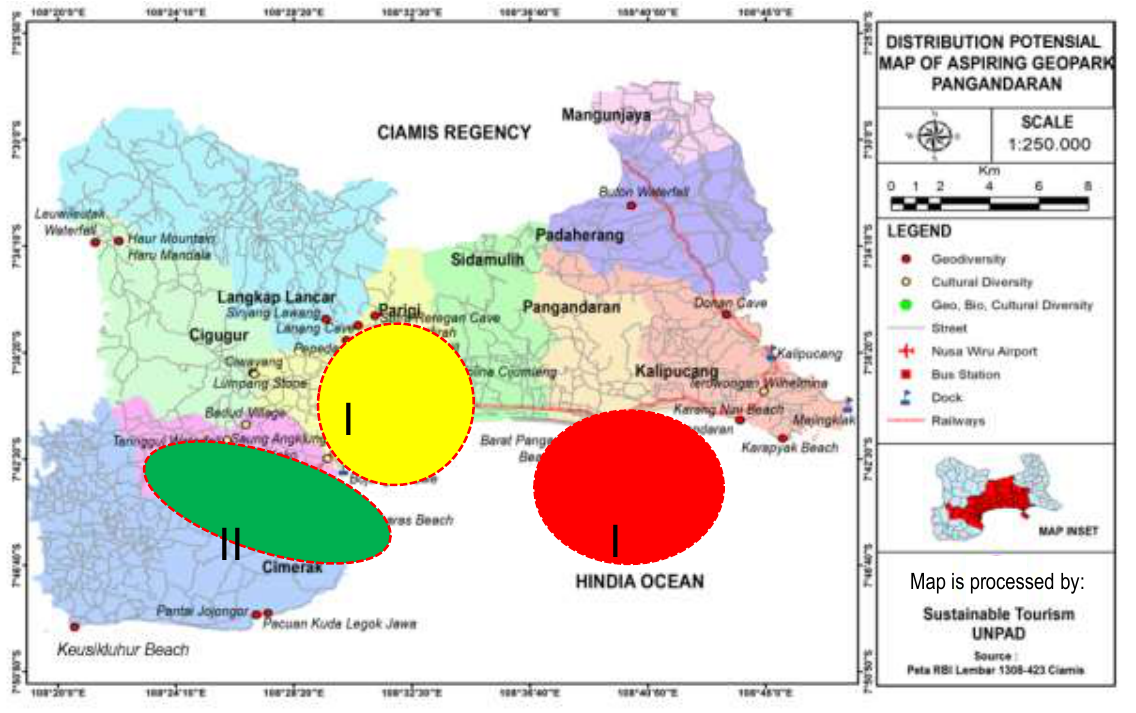
Figure 8. Distribution Potential Map of Aspiring Pangandaran Geopark (Source: processed by researchers,